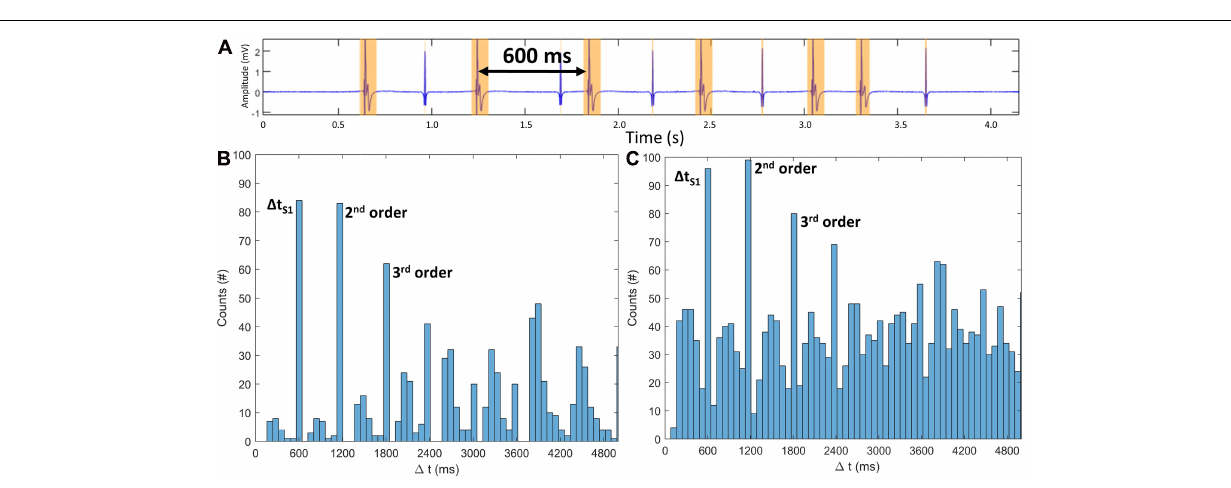
FIGURE 2 | (A) Active segment detection (yellow intervals) of a stimulation block segment of a synthetic 80-s-long S1S2 protocol with 20 randomly distributed extra beats – A shows 5 extra beats. S1 peaks have a cycle length of 600 ms. (B) Histogram of all time intervals between active segments. x -axis cut at 5000 ms. Time interval corresponding to S1 cycle length and the harmonics present the highest contribution. (C) Fourfold increase of extra beats does not change the three main